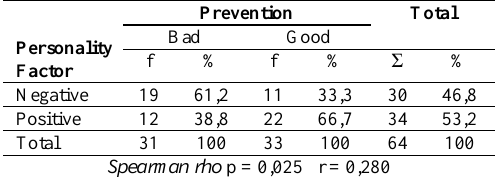
Table 4. Correlation between personality factor